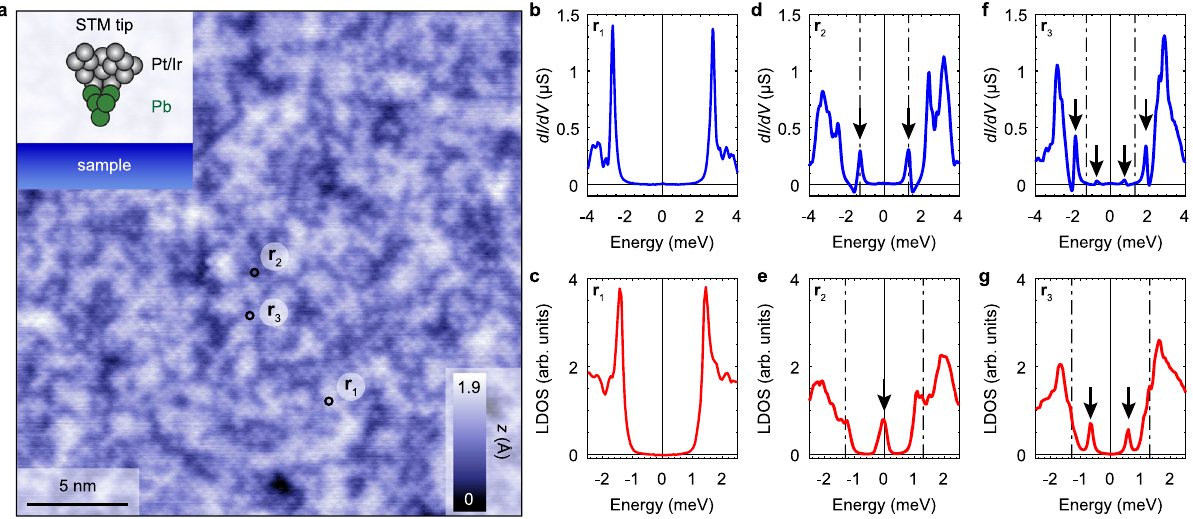
Fig. 1 Scanning Tunneling Microscopy on FeTe 0.55 Se 0.45 with a superconducting tip. a Atomically resolved topographic image ( z -height map, 25 × 25 nm 2 ) of FeTe 0.55 Se 0.45 cleaved surface acquired with a Pb coated Pt/Ir tip (see inset) at 2.2 K in ultra-high vacuum. Setup condition: V set = − 8 mV, I = − 100 pA. b , d , f Spatially averaged differential conductance spectra in the areas ( r set 1 , r 2 , r 3 ) marked by the black circles in a . r 1 : no in-gap states. r 2 : two in-gap resonances at ± 1.3 meV. r 3 : two sets of peaks symmetric in energy around the Fermi level. c , e , g Deconvolution of the spectra shown in b , d , f , respectively, provide information about the intrinsic LDOS of the sample in the indicated areas. In r 2 a zero-bias impurity state is recovered and in r 3 two in- gap states are observed. Setup conditions: b V set = 6 mV, I set = 1.2 nA, d, f V set = 5 mV, I set = 2 nA. Lock-in modulation is V mod ¼ 30 μ V peak-to-peak for all measured